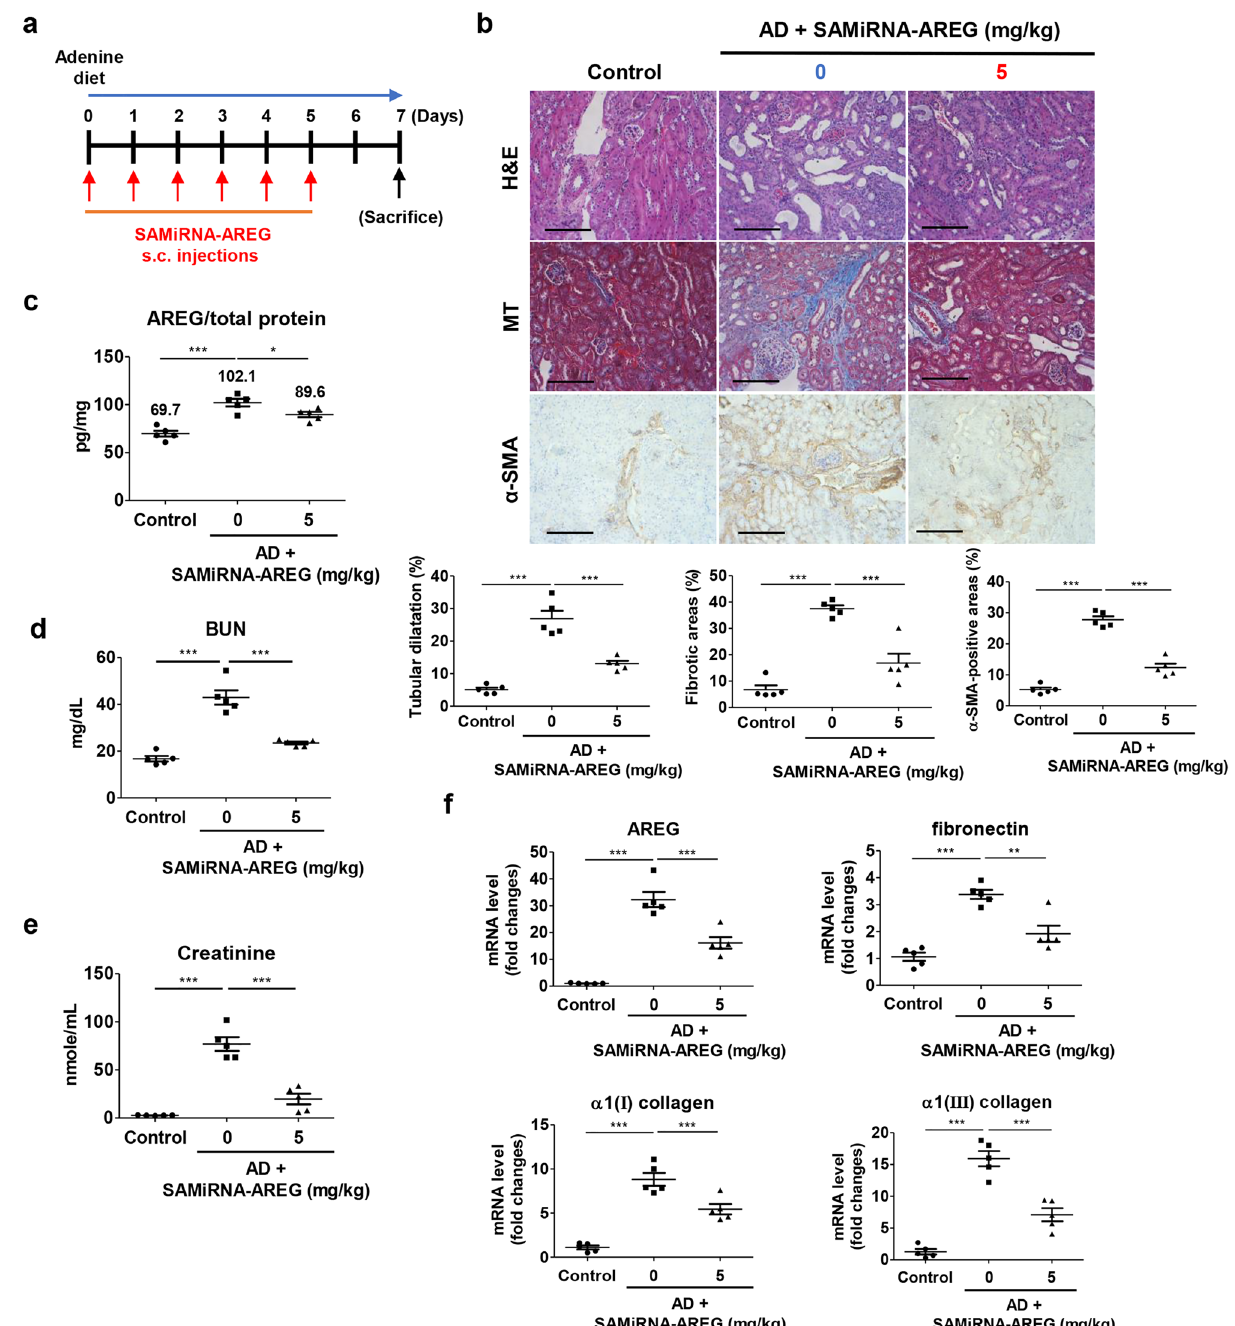
Figure 4. SAMiRNA-AREG ameliorated renal fibrosis in the AD-induced model. ( a ) Time scheme for SAMiRNA-AREG efficacy analysis in AD mice. ( b ) Histological analysis by H&E, MT, and IHC staining of control, UUO, or SAMiRNA-AREG-treated AD mice. Tubular dilatation, fibrosis areas, and α-SMA-positive areas were quantified. Scale bar, 100 μm. ( c ) AREG proteins in kidney tissue lysates were measured by ELISA. The numbers indicate the mean value of each data set. ( d , e ) BUN and serum creatinine were measured by ELISA. ( f ) Kidney tissue lysates were subjected to real-time qRT-PCR analysis for AREG, fibronectin, α1(I) collagen, and α1(III) collagen (mean ± SEM). * p < 0.05, ** p < 0.01, *** p < 0.001 compared with AD mice by ANOVA with the Newman-Keuls post-hoc